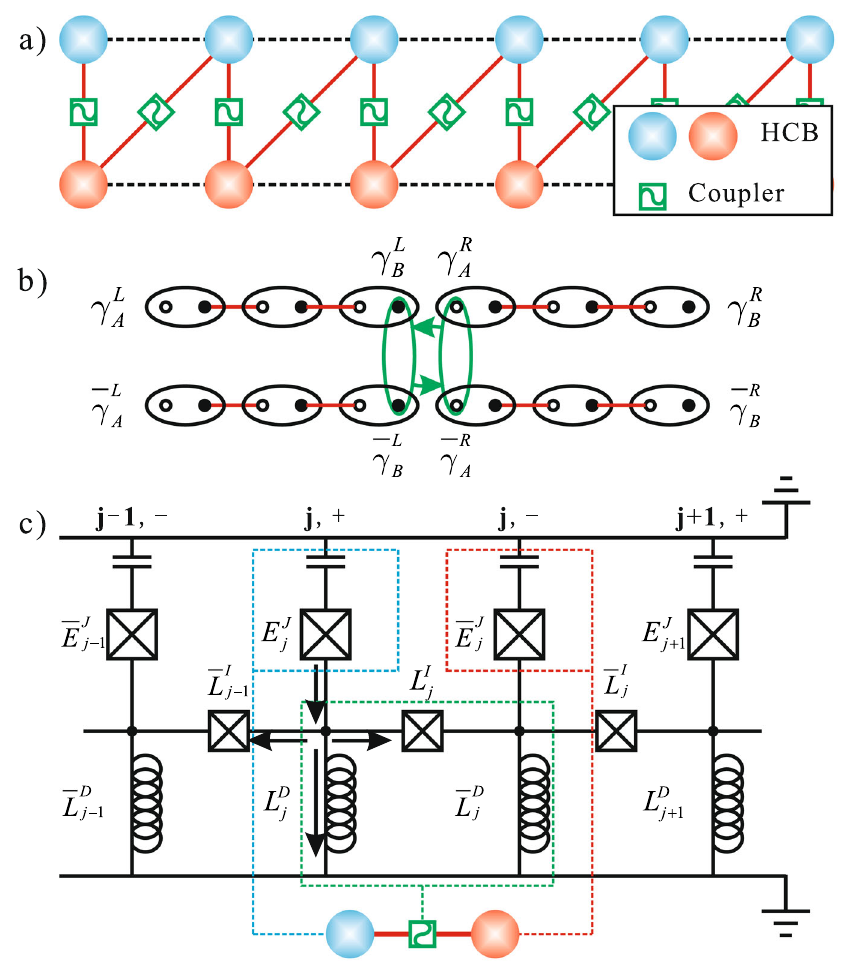
Fig. 1 a Schematic view of the 1-D HCB simulator of H DIII . The solid red line describes the path along which the HCB sites are physically coupled and the bosonization is performed. Through the DDM of the nearest neighbor coupling (the green wavelet boxes ) the effective intra- species hopping and pairing (the black dashed lines ) can be induced. The 12-HCB lattice shown is minimal for the demonstration of universal quantum operations. b Realization of nontrivial two-qubit gate in the 12-HCB lattice. In the situation w = Δ and μ = 0, each HCB site (the ellipse) can be decomposed into two Majorana modes (the fi lled and the hollow dots ) pairing in the bulk. Two topological qubits can be prepared by “ cutting ” the whole DIII chain into two pieces. Through the modulation of (3, − ) ↔ (4, + ) coupling, the effective γ L coupling can be induced. c Schematic plot of the array of coupled transmon